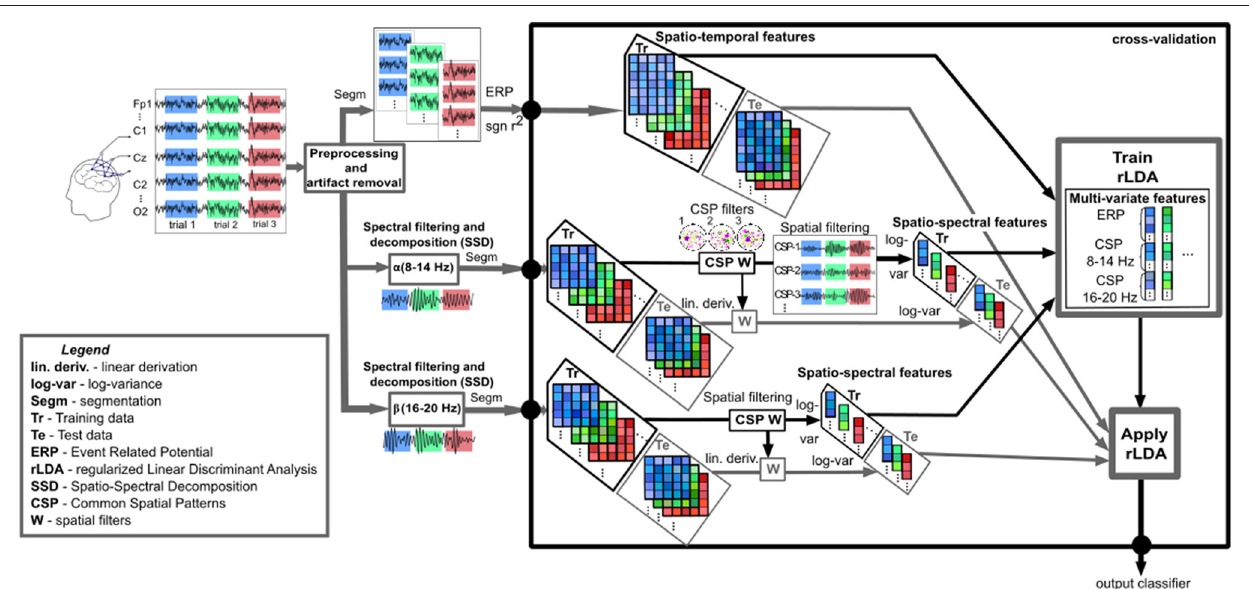
FIGURE 4 | Outline of the data analysis chain. The preprocessed neural data is analyzed in the temporal domain (ERPs based on signed r 2 ) and the spectral domain (spectral filtering and decomposition in the α (8–14 Hz) and β (16–20 Hz) bands). All three types of feature vectors: the spatio-temporal features (meaning the most important temporal points based on the maximum signed r 2 intervals, the spatio-spectral features (log-variance of the CSPs) in the α and β bands, are concatenated and given to the classifier within crossvalidation. Due to label information employment, spatio-spectral filtering considers the optimal channel and frequency band using CSP analysis with automatic filter selection computed on the training set (CSP W) and applied to the test set by linear derivation (W). SSD and the interval selection method based on signed r 2 were applied to the whole dataset and not within crossvalidation. While this aspect of the validation is not perfectly sound, the expected overestimation of the performance is limited. Finally, the classifier (regularized Linear Discriminant Analysis with shrinkage of the covariance matrix) decides the corresponding class membership for each trial (output classifier), representing the cognitive processing